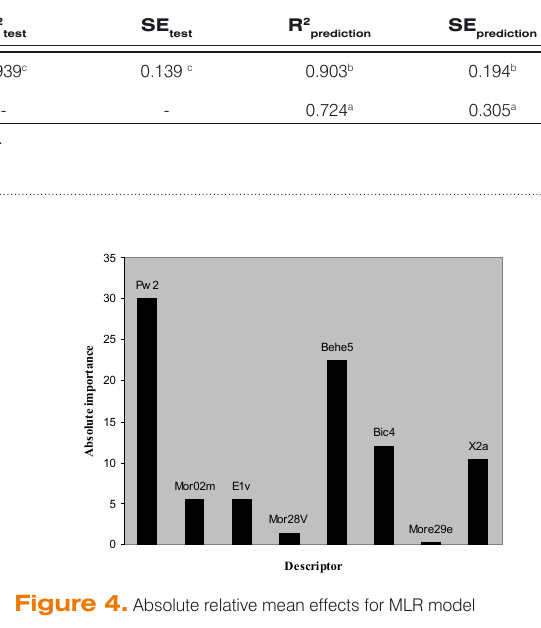
Table 4. Statistical results of STANN model compared to GA-MLR model